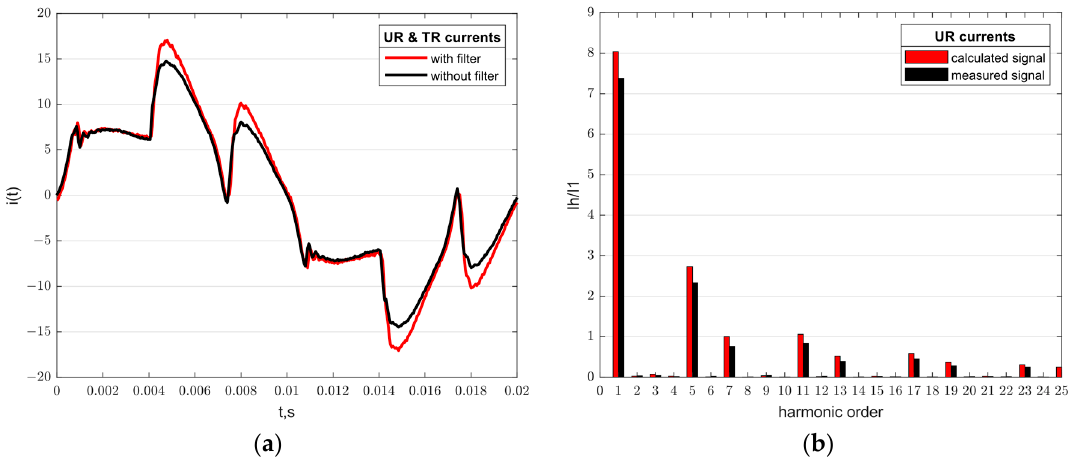
Figure 9. The waveforms ( a ) and harmonic spectrum ( b ) of aggregated load currents with filter.